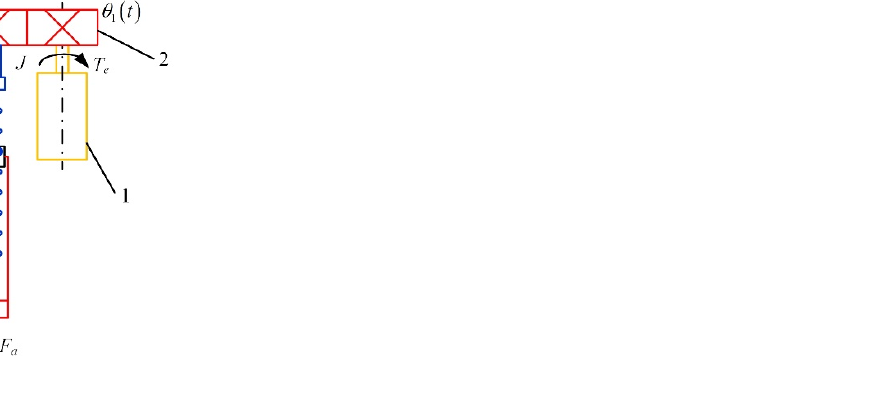
Figure 5. Stress analysis diagram of the pillar cuttage using an electric push rod. 1: brushless motor; 2: reducer; 3: nut assembly; 4: ball screw; and 5: push pole.